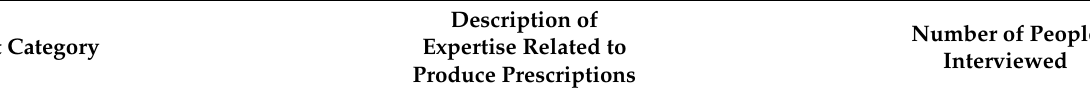
Table 1. Description of key-informant